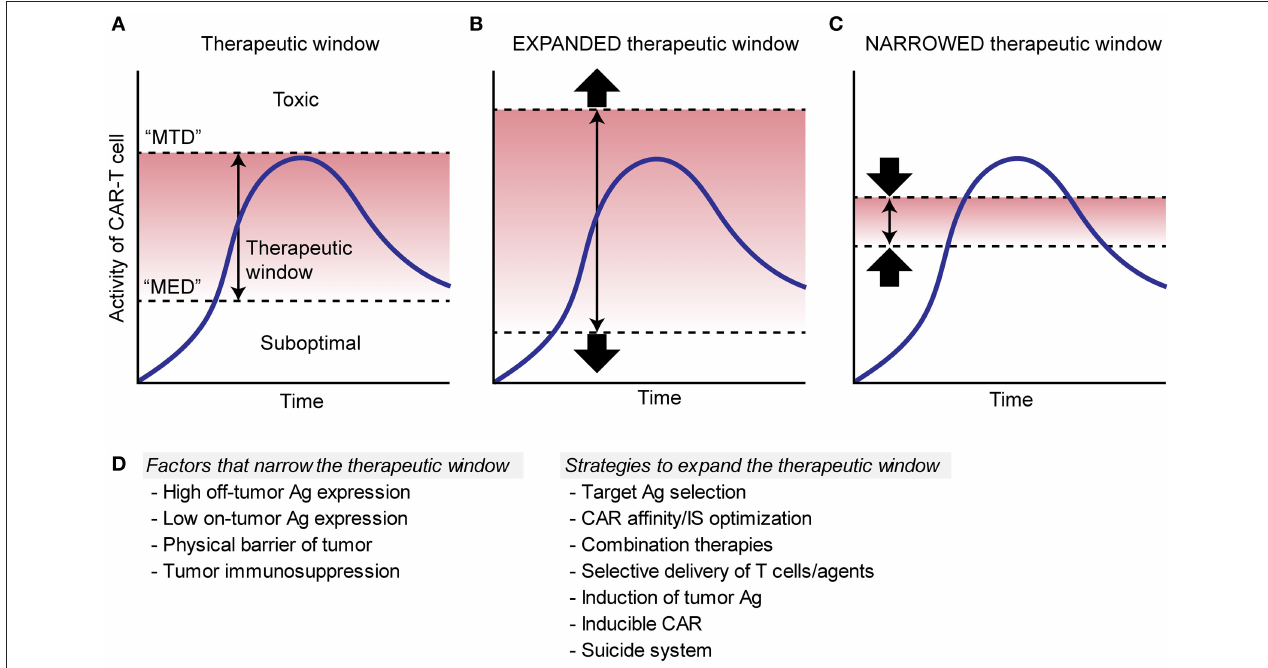
FIGURE 2 | Schema to illustrate therapeutic window of CAR T cell therapies. (A) . Therapeutic window (red area) is determined as a range between the minimum effective dose (“MED”) and the maximum tolerated dose (“MTD”), where the therapy can achieve the highest therapeutic benefit without resulting in unacceptable toxicity. Blue lines show the kinetics of CAR T cells. (B) . Red area shows an expanded therapeutic window with decreased “MED” and/or increased “MTD,” which increase a chance for the CAR T cells to induce sufficient efficacy without toxicity. (C) . Red area shows a narrowed therapeutic window with increased “MED” and/or decreased “MTD,” which can cause toxicity and/or suboptimal efficacy. (D) . Factors that can narrow the therapeutic window and possible strategies to expand the window are